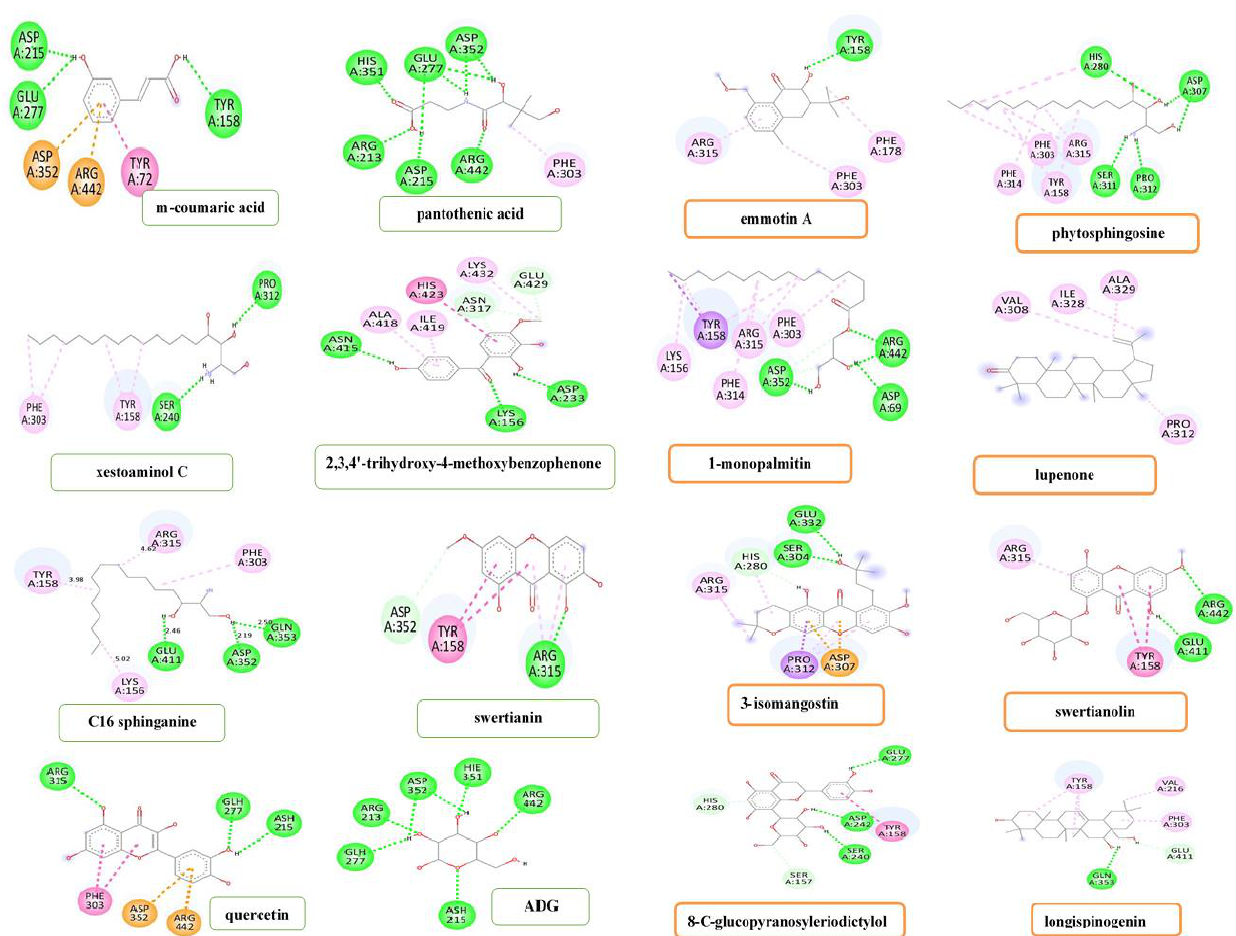
Figure 4. The 2D diagram of the α -glucosidase (3A4A) and 14 compounds, quercetin and ADG binding interactions.